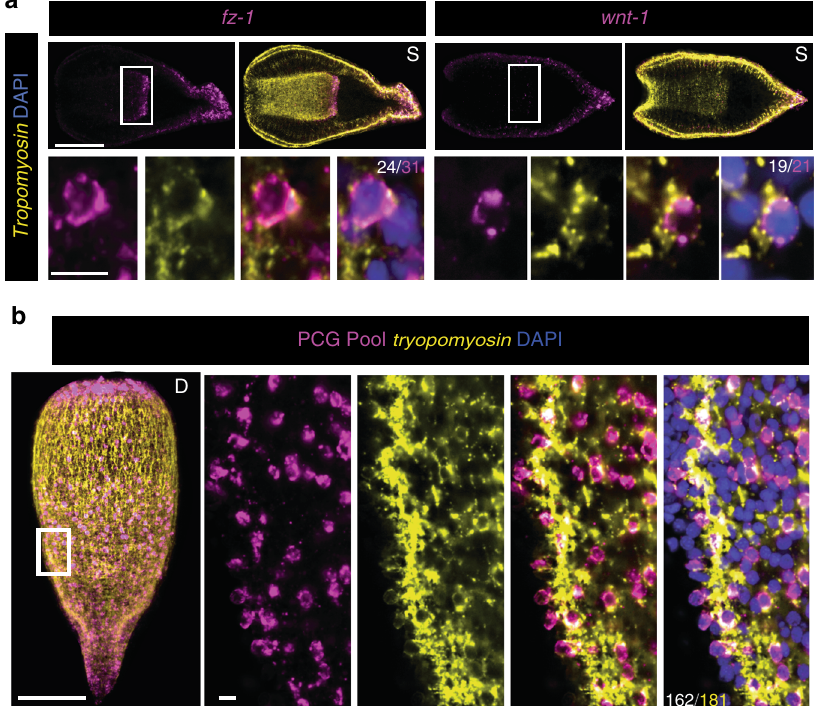
Fig. 3 PCG expression is a major attribute of Hofstenia muscle. a The posterior PCGs frizzled-1 and wnt-1 were expressed both in the body wall and interiorly. The interior expression was speci fi c to tropomyosin -positive pharyngeal muscle fi bers. b Co-expression of PCGs and tropomyosin , detected with hybridization of seven pooled PCG probes as in Figs. 1c and 2b. Quanti fi cation was speci fi c for region shown. Denominator is total number of tropomyosin - positive nuclei; numerator is the total number of double-positive. a , b 100 μ m, overview image; 10 μ m, cell inset. D dorsal view, S coronal section. Overview images are representative of 5/5 animals